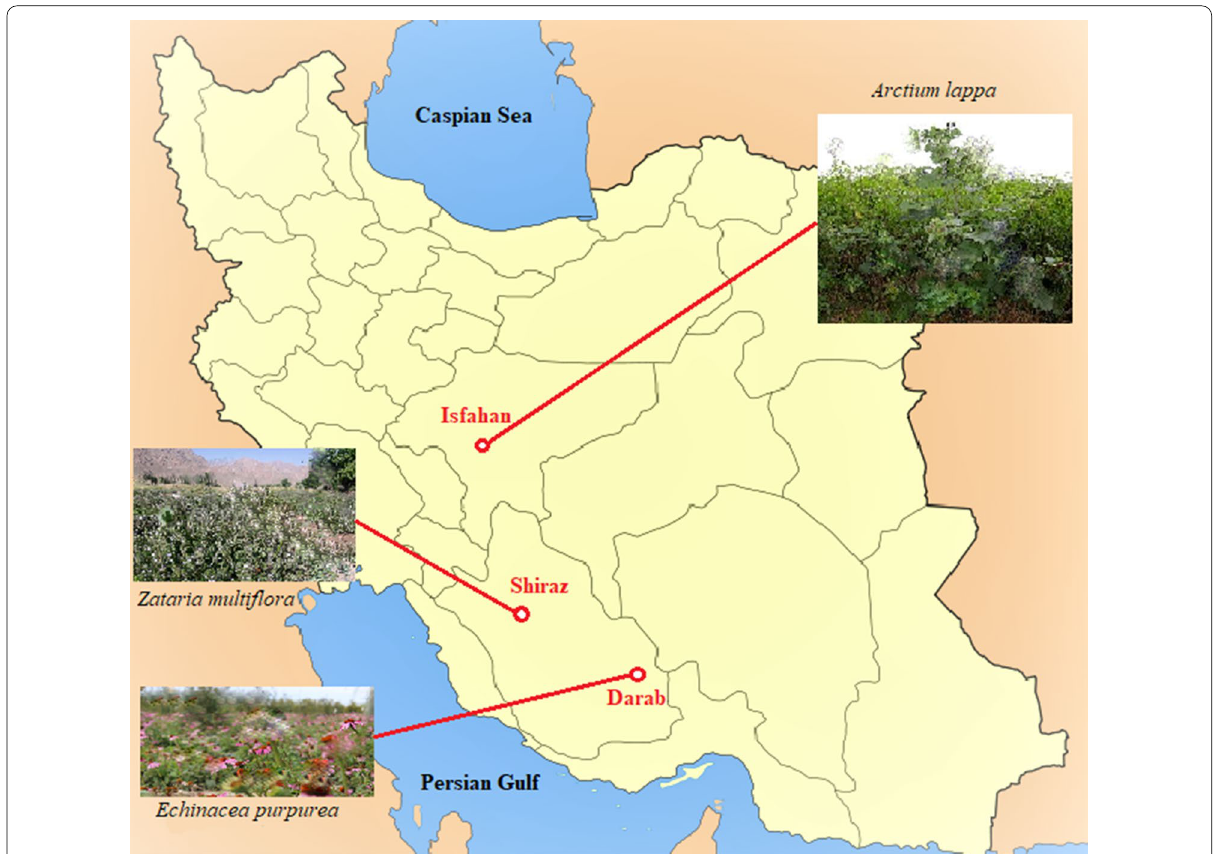
Fig. 1 Locations of farms for